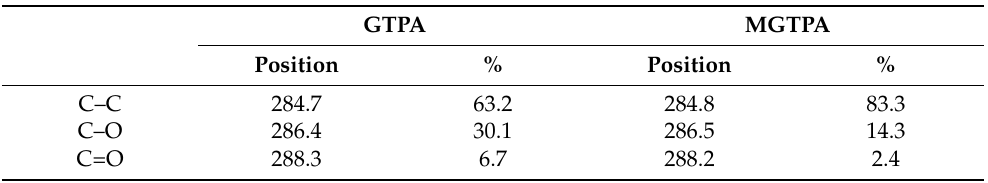
Figure 2. The FTIR spectra of the ( a ) TOCN, ( b ) GO, ( c ) PVA, ( d ) GPTA, and ( e ) MGPTA. To further confirm that the DDTS was grafted to the hydroxyl groups during CVD modification, X-ray photoelectron spectroscopy was carried out (Figure S4). We detected carbon and oxygen from GTPA, while MGTPA showed silicon peaks from DDTS. The curves were Gauss fitted to indicate the proportion of different bonds (shown in Table 1). The high-resolution C1s core-level spectra show that the proportion of C-C bonds increased from 63.2% to 83.3% due to the grafting of long carbon chains (Figure 3b,c). In the mod- ified TOCN/PVA/GO spectrum (Figure 2e), the intensity of the –CH 2 bonds (2850 and 2918 cm − 1 ) increased, while the intensity of the -OH (3400 cm − 1 ) bonds decreased, in- dicating the grafting of hydrophobic carbon chains after CVD modification, which is in agreement with the XPS results. Table 1. The proportion of different bonds of XPS.